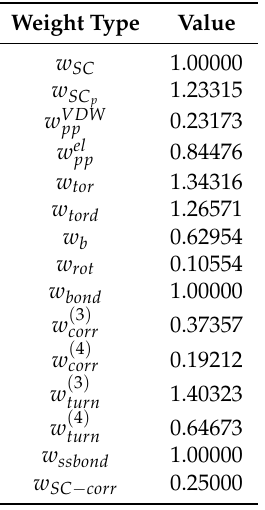
Table 1. Optimized weights for the EL variant of